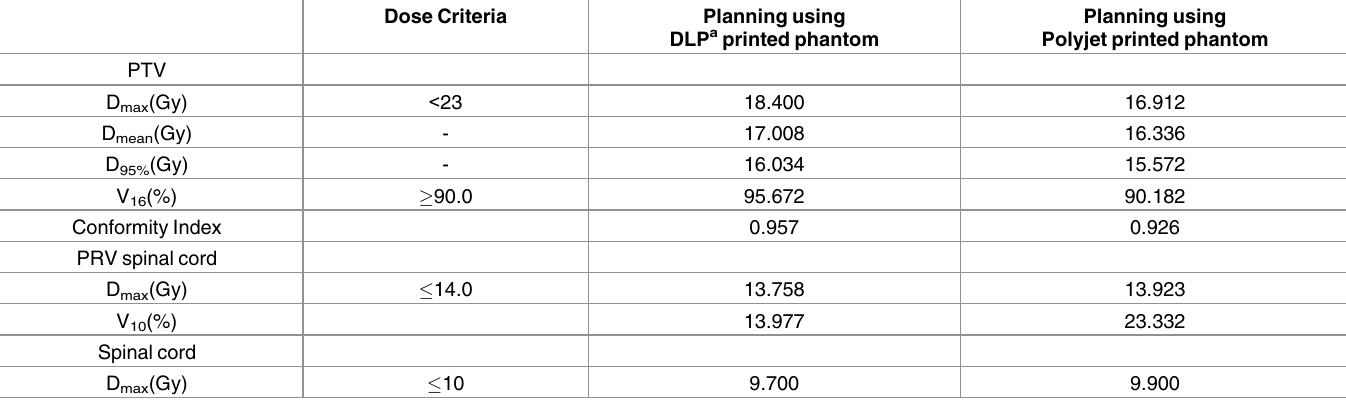
Table 3. Summaryof the dosimetric results for the planning target volume (PTV) and organs at risk (OAR) for treatment planning using two differ- ent 3D printed phantom image sets.